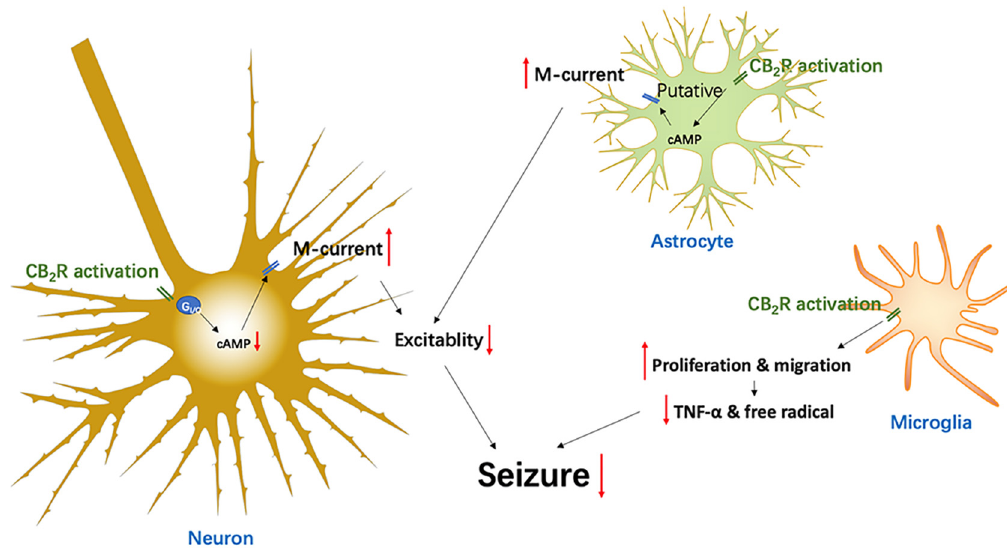
Figure 1. Diagram epitomizing the CB 2 R-associated mechanisms in the modulation of epileptic seizures.